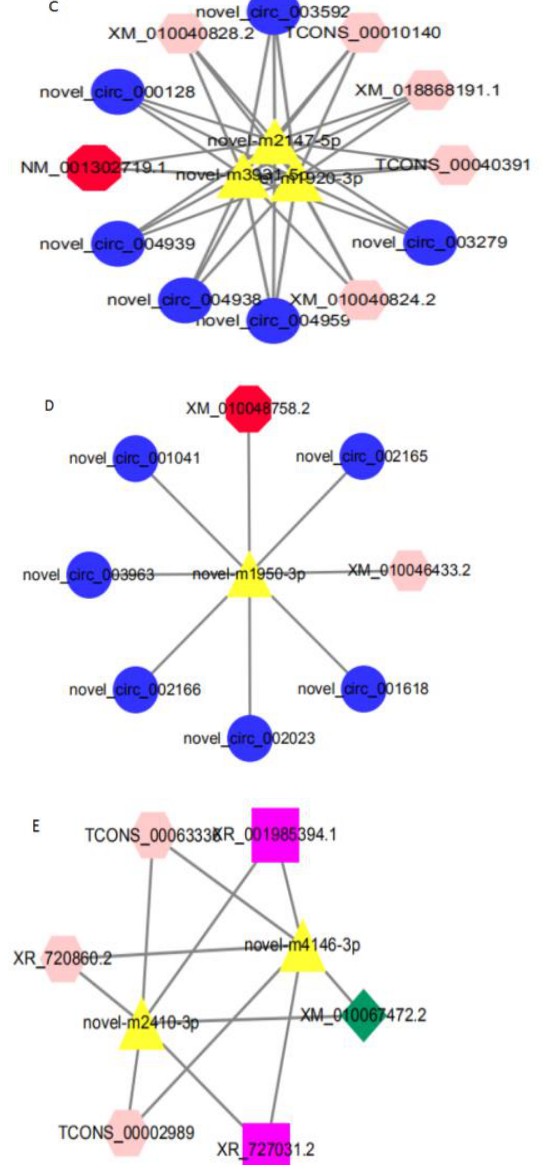
Figure 5. lncRNA-mRNA co-expression network. Pink and red hexagons represented lncRNAs and mRNAs, magenta squares represented mRNAs, green diamonds represented mRNAs, yellow triangles represented miRNAs, and blue circles represented circRNAs. ( A ), 4 lncRNAs, 19 mRNAs, and 17 circRNAs; ( B ), 10 lncRNAs, 18 mRNAs, and 2 circRNAs; ( C ), 5 lncRNAs, 1 mRNAs, and 6 circRNAs; ( D ), 1 lncRNA, 1 mRNA, and 6 circRNAs; ( E ), 3 lncRNA, 2 mRNA, and 1 circRNAs.